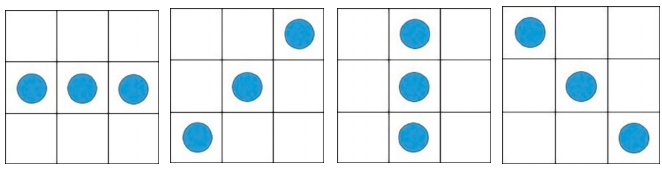
Figure 3. 0°, 45°, 90° and 135° structuring elements. Figure 3. 0 ◦ , 45 ◦ , 90 ◦ and 135 ◦ structuring